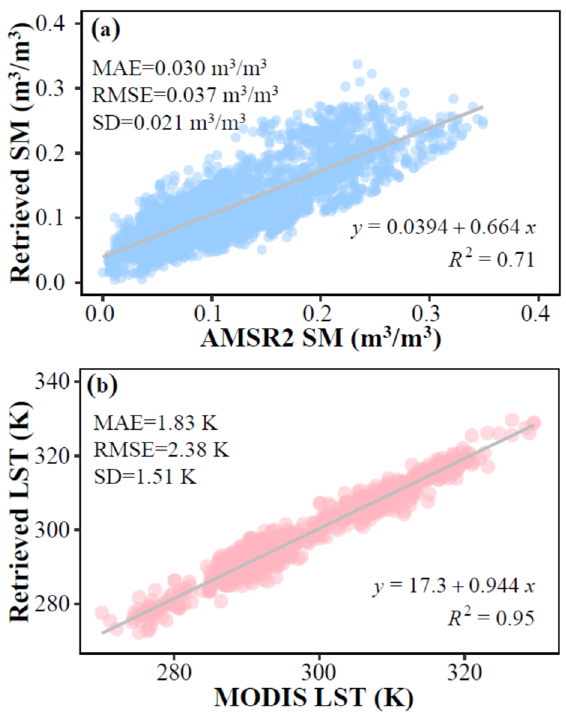
Figure 8. Cross-validation of ( a ) SM and ( b ) LST retrieved by the MDK-CR method and with AMSR2 SM and MODIS LST.